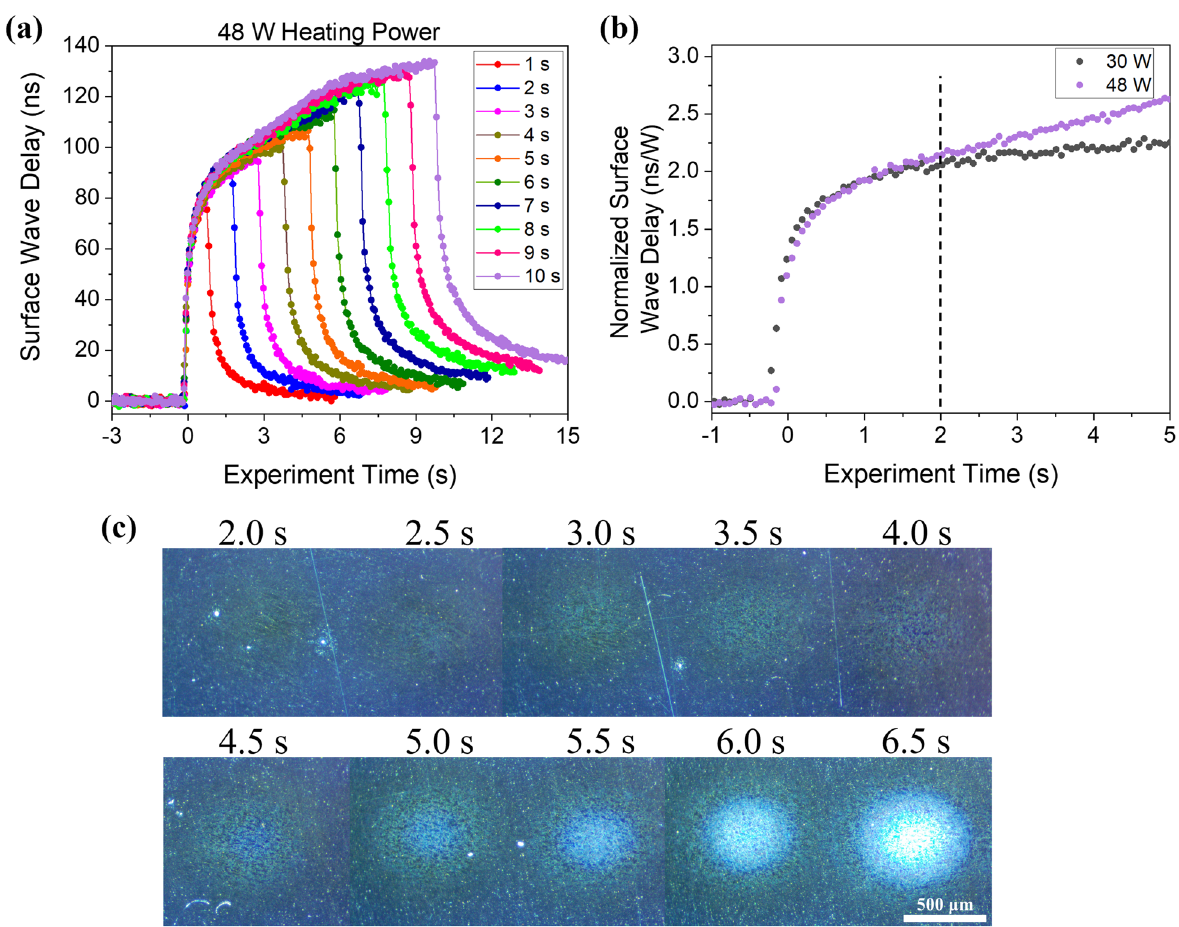
Figure 7. ( a ) Subset of surface wave delay data from the incremental heating experiment at a fixed laser power of 48 W. ( b ) Zoom-in of the normalized surface wave delay for heating laser powers of 30 W and 48 W. ( c ) Optical micrographs of the sample surface after the indicated times of heating.